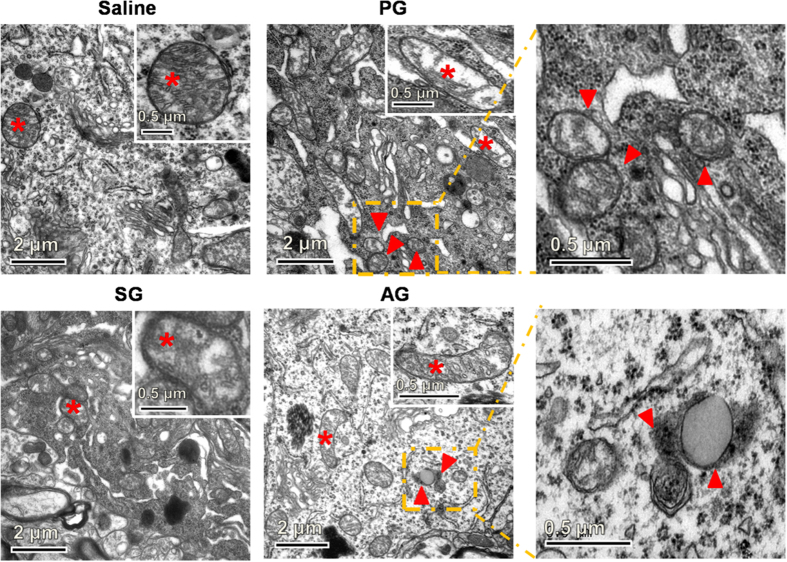
Transmission electron microscope (TEM) images for neuron cells in each group(7th day after last MPTP injection).Arrowheads: autophagosome; asterisk: mitochondria, Scale bar: 2 μm; inset: magnified image for mitochondria(Scale bar: 0.5 μm).